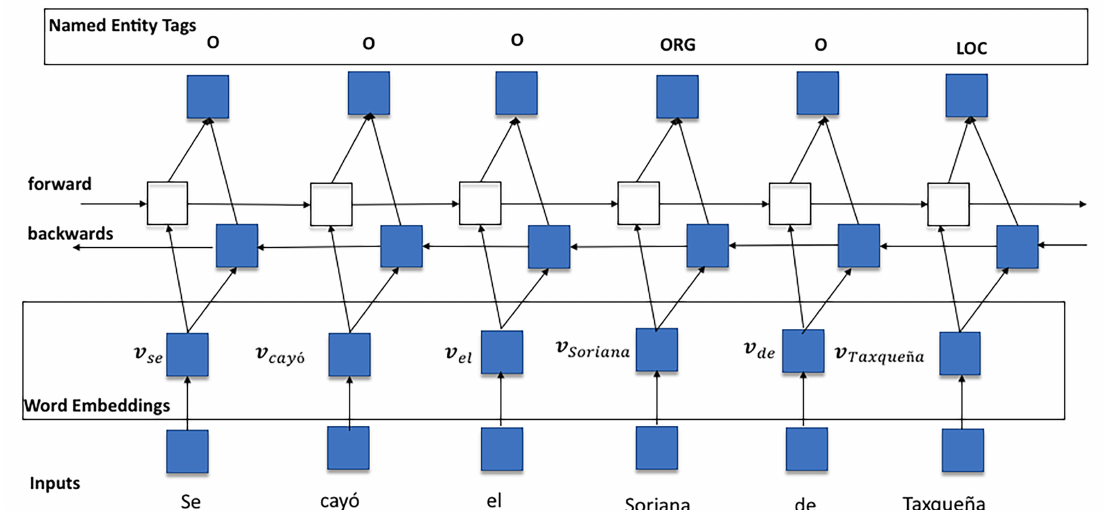
Figure 4. A biLSTM network for NER tasks. English Translation: Taxqueña’s Soriana has fallen down